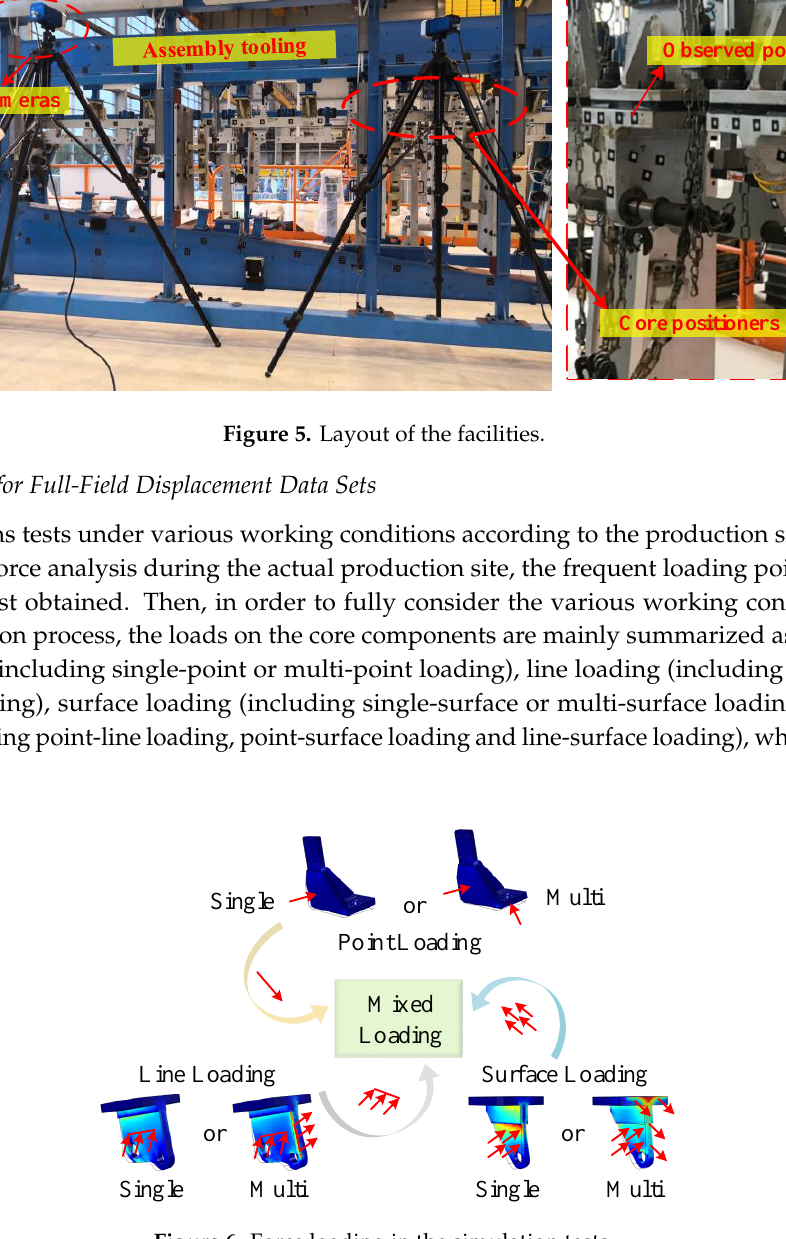
Figure 6. Force loading in the simulation tests.